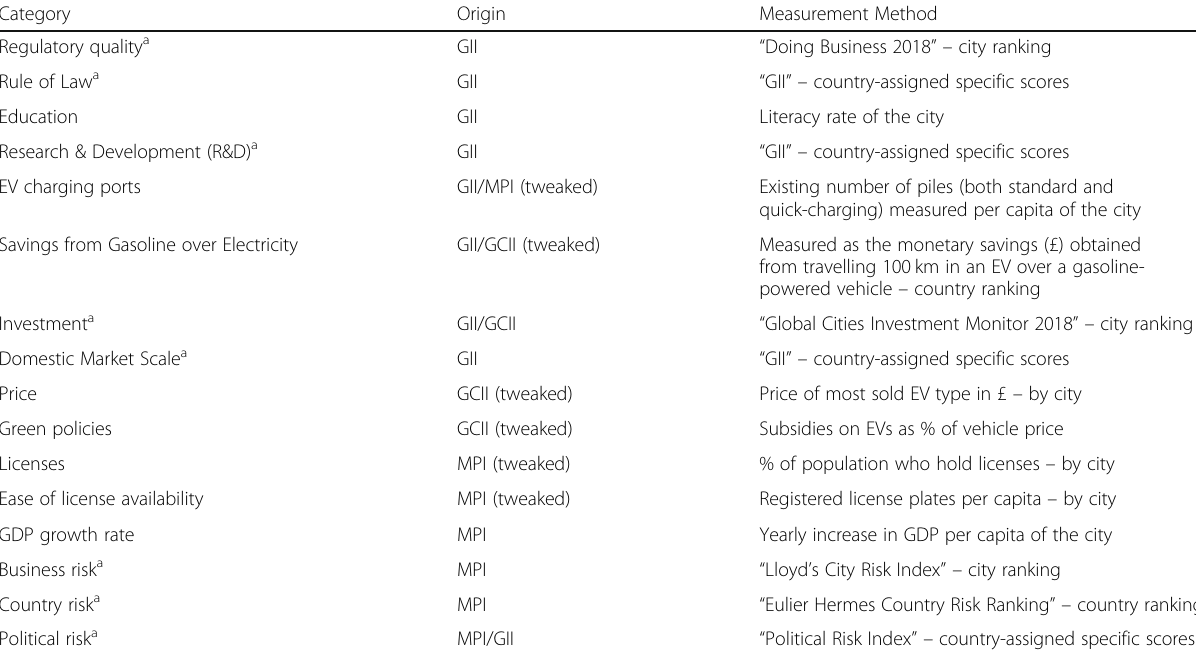
Table 2 Final index categories (author ’ s